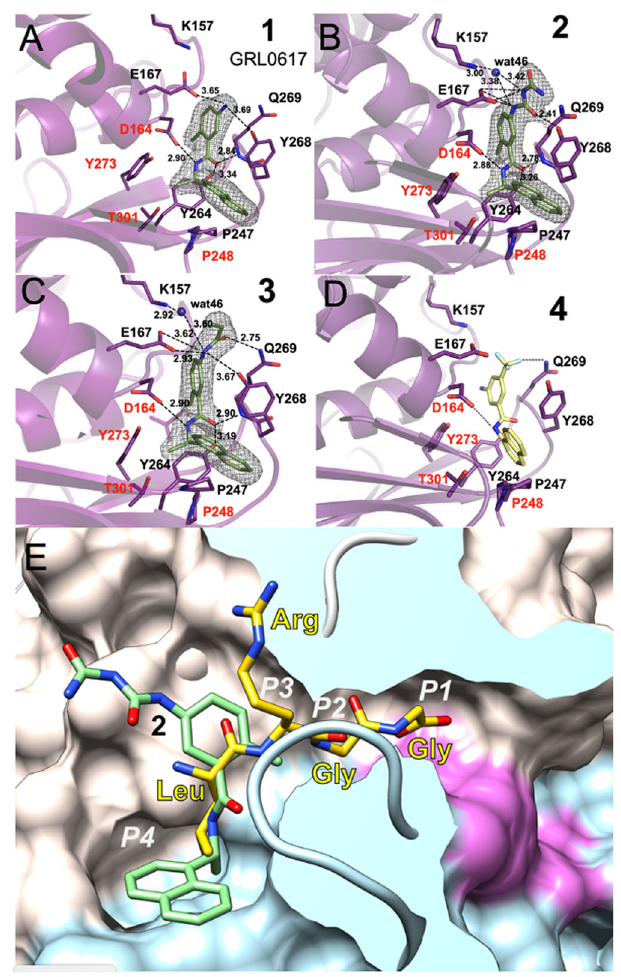
Fig. 4 Ligands binding to SARS-CoV-2 PLpro. A Compound 1 binding to PLpro. B Compound 2 binding to PLpro. C Compound 3 binding to PLpro. D Model of compound 4 (yellow sticks) binding to PLpro. Ligands are shown as green sticks and PLpro is in magenta. Dashed lines show hydrogen bonds, water molecules are shown as blue spheres. In A – C the 2 F o − mF c electron density maps are shown as a grey mesh, contoured at 1.2 σ . E Compound 2 (green sticks) binds to a groove on the surface of PLpro protein (surface of palm subdomain is in white and thumb subdomain is in light blue) with the active site catalytic triad surface is shown in red in the end of a slender tunnel. Peptide LRGG from ubiquitin structure in complex with SARS PLpro (PDB id: 4MOW) is shown in yellow and peptide positions corresponding P1 – P4 sites are marked in